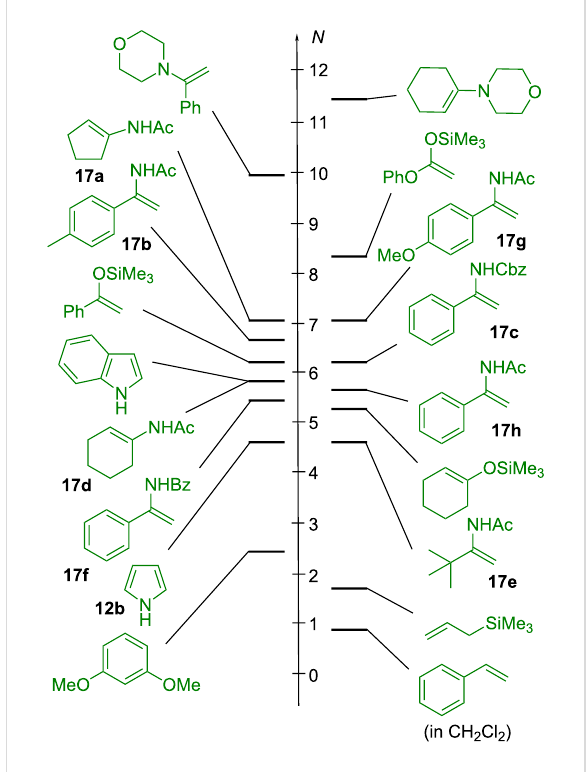
Figure 12: Comparison of the nucleophilicities of enamides 17 with those of several other C nucleophiles (solvent is CH 3 CN unless other- wise mentioned, N values taken from